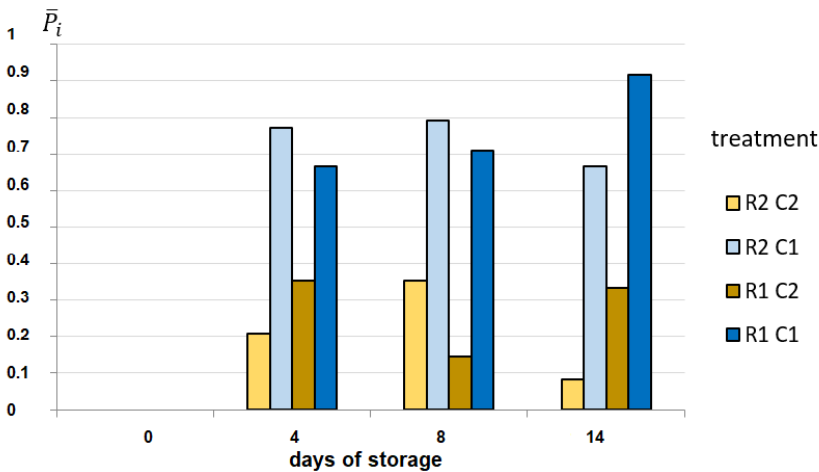
Figure 5. The Panel Preference ( P i ) for the oil extracted from the ‘Arbequina’ cultivar, recollected with a Manual Inverted Umbrella (R1) or in a traditional way (R2) and stored for 4, 8, and 14 days at 5 °C (C1) or at ambient temperature (C2). The panel was formed by 8 approved tasters. Data at day 0 are not shown as the Friedman test cannot be performed on two treatments.